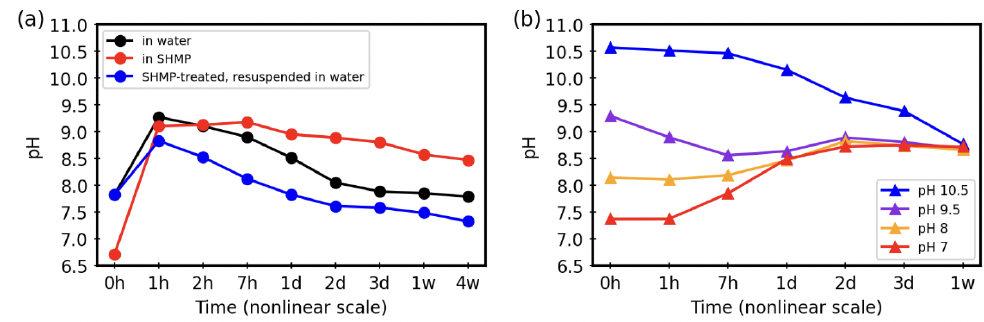
Figure 4. Representative pH vs . time trends for ( a ) SHMP-treated samples (annealed, SHMP-treated, and re-suspended SHMP-treated powders; see also Figure 2) and ( b ) orthophosphate-treated samples (different starting pH values, all at 10 mM; see also Figure